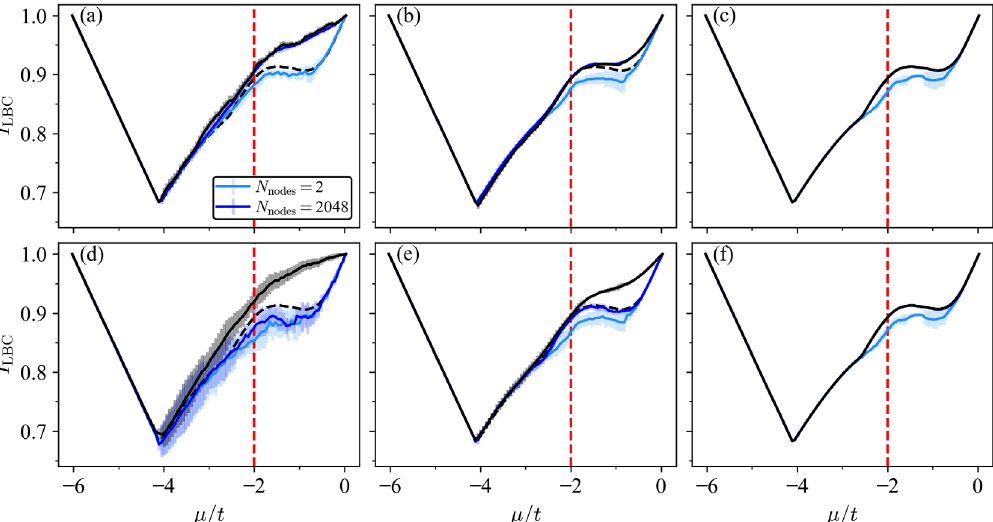
FIG. 16. Results of LBC for the Kitaev chain ( L ¼ 10 ) using NNs composed of a single hidden layer with 2 or 2048 nodes for various M M = 5 . The tuning parameter p ¼ μ =t ranges from numbers of training samples M per parameter value, where M train valid ¼ test ¼ train 0 with Δ p ¼ 0 . 06 . The critical value μ p 1 ¼ − 6 to p =t ¼ − 2 is highlighted by a red dashed line. The optimal indicator obtained K ¼ c based on the corresponding dataset or the ground-truth probability distributions is highlighted by a black solid or dashed line, 10 , (b) M 10 2 , and (c) M 10 5 , where respectively. (a) – (c) Indicator I of LBC evaluated on the training set for (a) M LBC train ¼ train ¼ train ¼ 10 , the NN-based predictions are obtained after training. (d) – (f) Indicator I of LBC evaluated on the test set for (a) M LBC train ¼ 10 2 , and (c) M 10 5 , where early stopping is performed by minimizing the validation loss. Similar results are obtained (b) M train ¼ train ¼ when evaluating the NNs at the end of training instead. Each NN is trained for 10 000 epochs with a learning rate of 0.005. The results are averaged over ten independent datasets, and the error bars are given by the standard